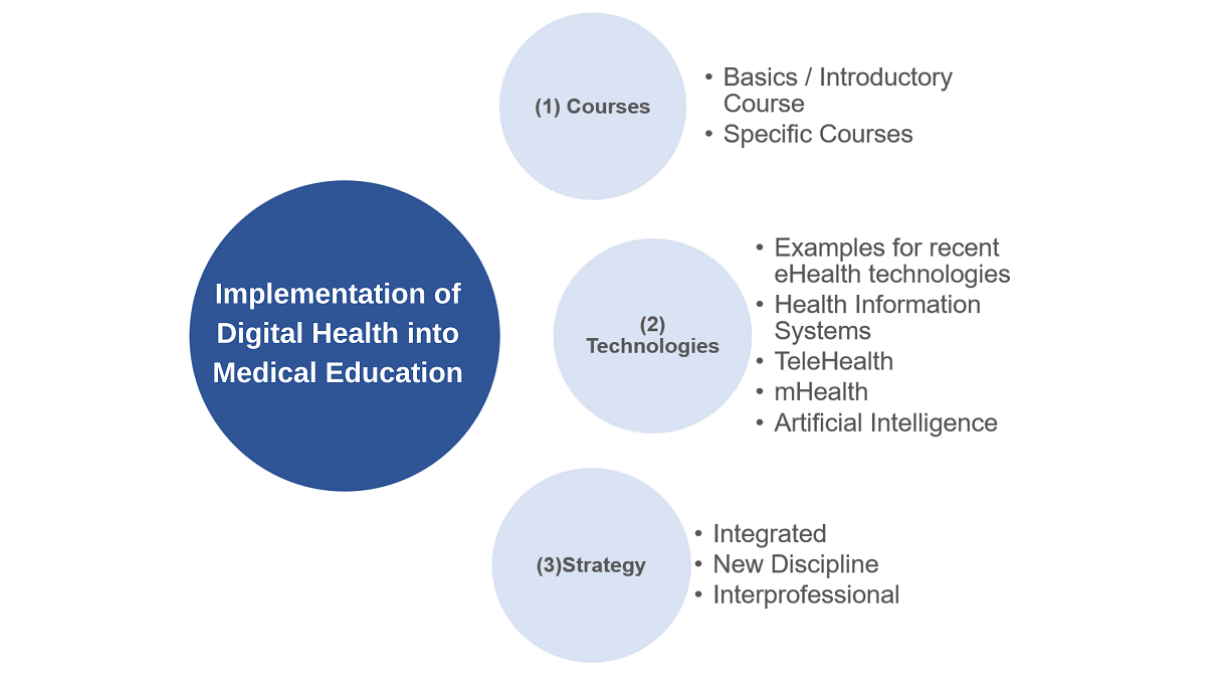
Figure 6. Free text categories derived from responses to the question: "What specific eHealth courses would you like to be implemented in your university’s